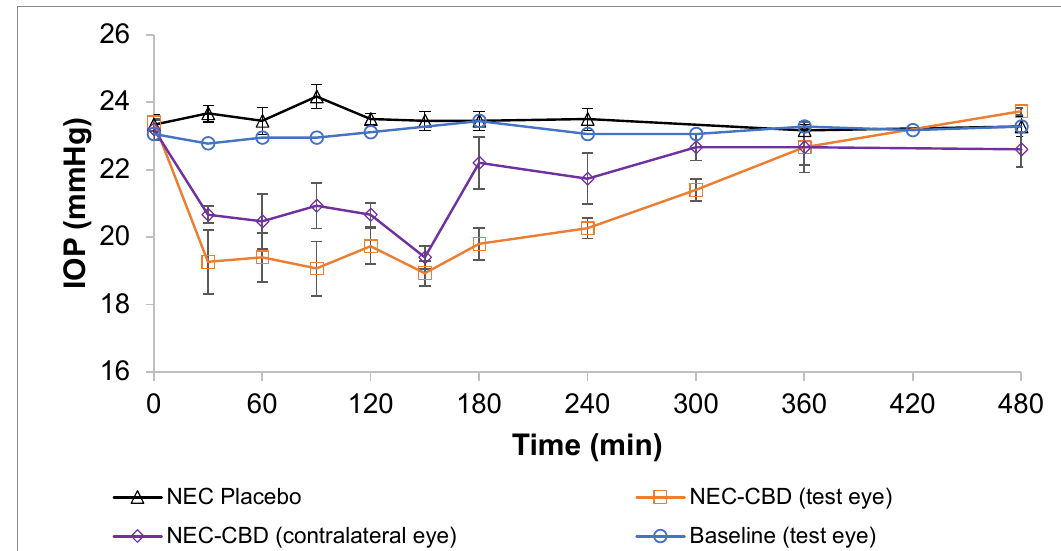
Figure 2. IOP vs. time profile following topical administration of CBD-NEC (treated eye and contralateral eye), NEC placebo (treated eye), and baseline of left eye in Dutch Belted male rabbits (mean ± SEM, n = 6). Table 4. p -values associated with the difference in the IOP values of treated and contralateral eyes from the baseline value post-instillation of CBD-NEC or placebo formulations in the Dutch Belted male rabbits ( n = 6).